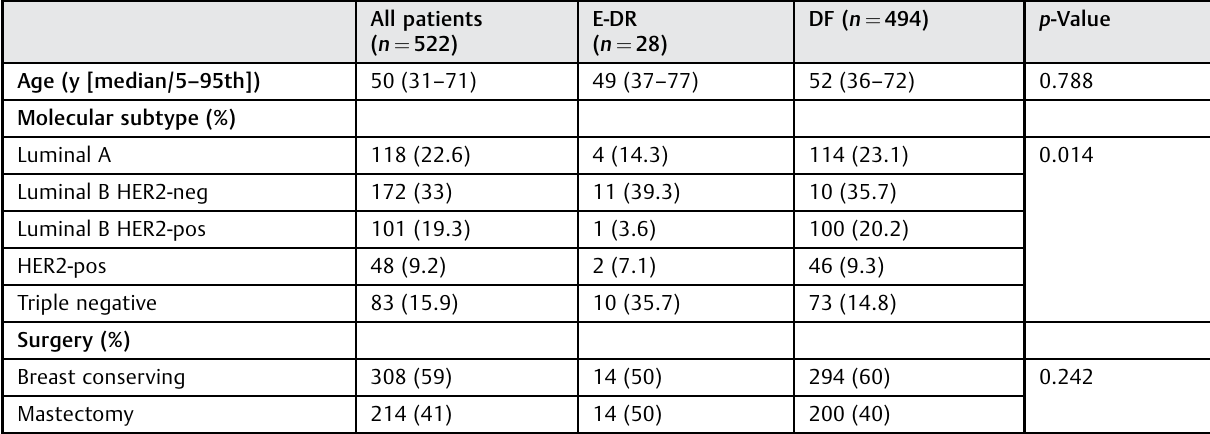
Table 1 Baseline characteristics of the overall cohort of patients and according to disease recurrence All patients ( n ¼